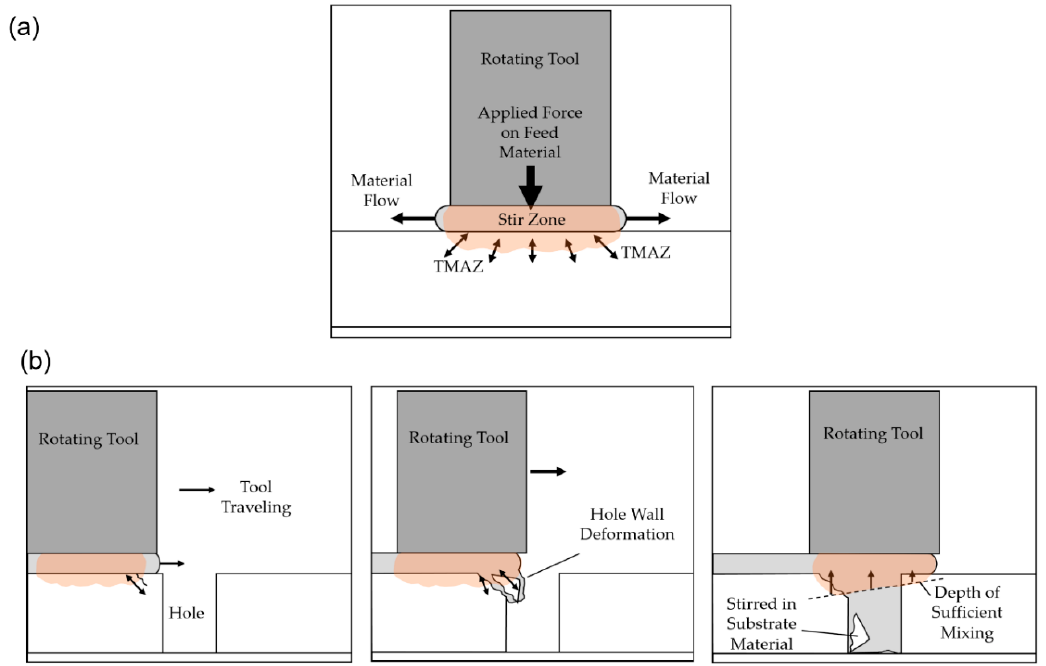
Figure 9. ( a ) Illustration of the deformation zones in additive friction stir deposition; ( b ) illustration of the interaction between the deposited material and the hole edges during hole filling using additive friction stir deposition.